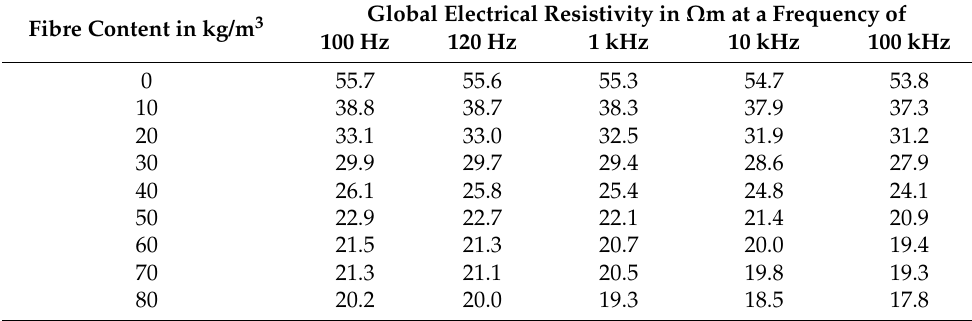
Table A15. Results of the resistivity measurements of the concrete mixture 42-60-300-00.